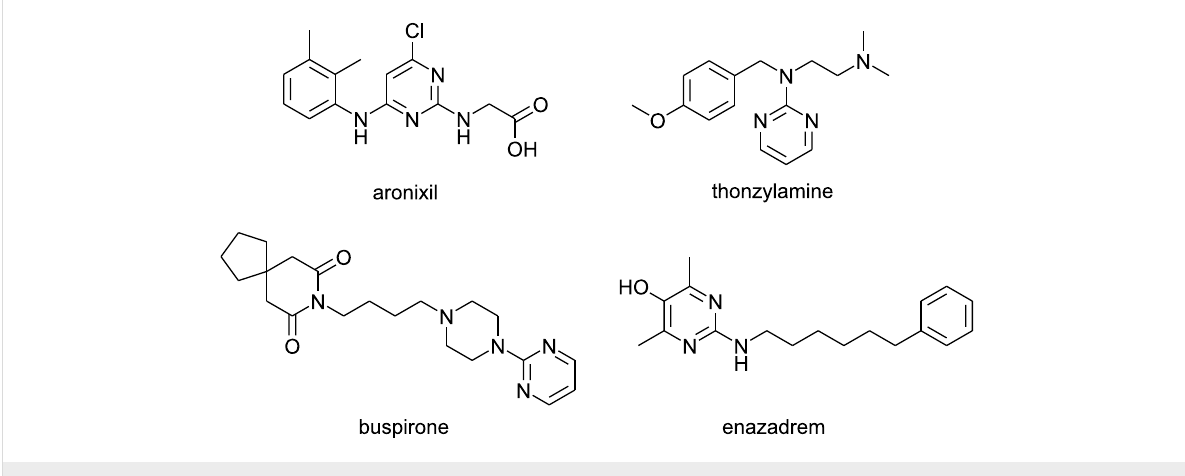
Figure 1: Pharmaceuticals with pyrimidine